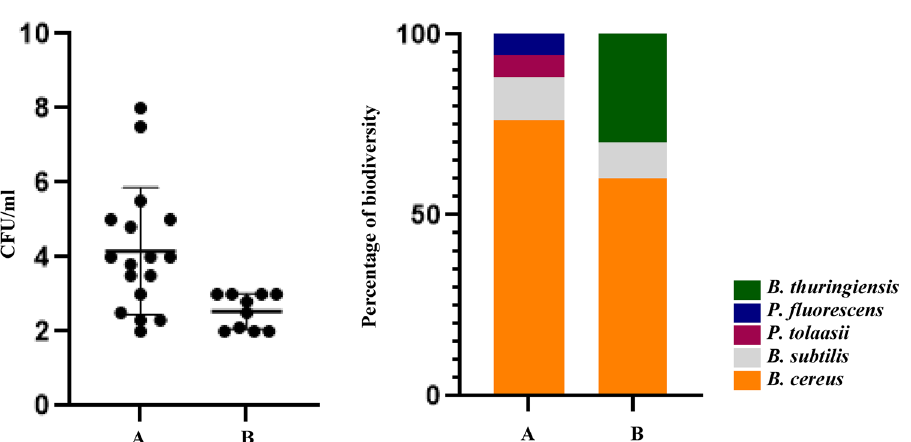
Figure 1. Changes in biodiversity and biomass of microbiome in response to silt and sand-based soils ( A) . Colony counting of microbiome isolated from sampling locations ( B) . Diversity of microbiome isolates collected from locations A and